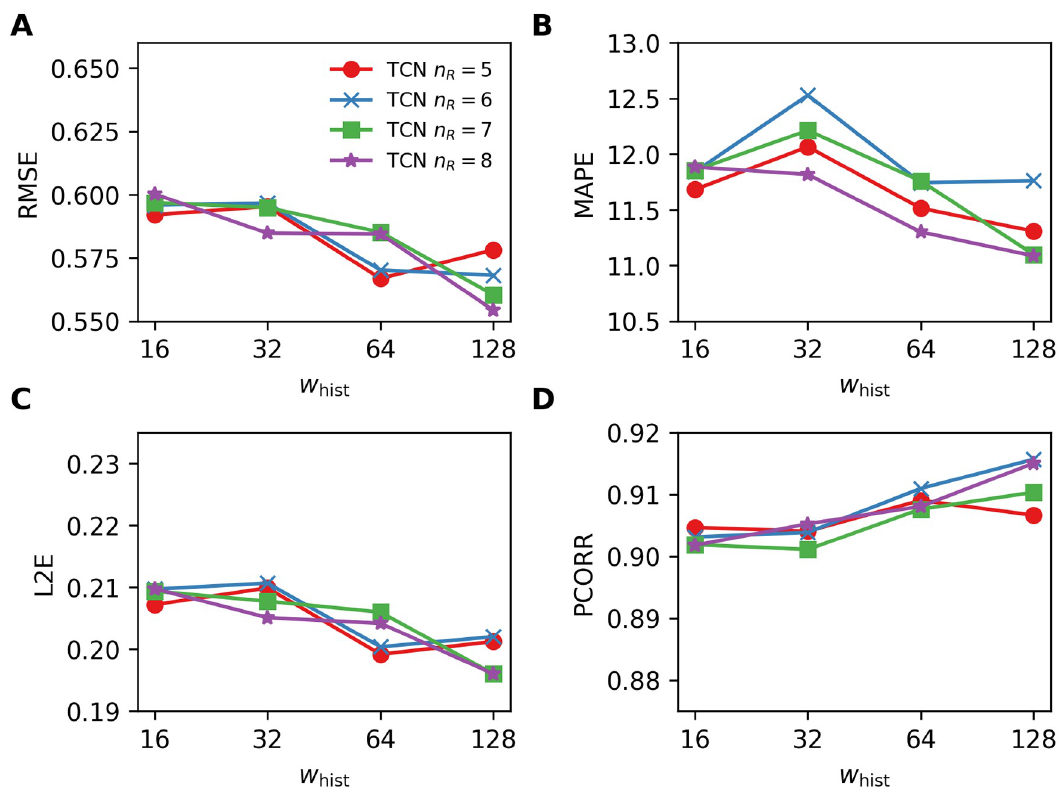
Fig 9. Four performance metrics for one-week-ahead predictions obtained by using the TCNs for varying number of residual blocks n R = {5, 6, 7, 8} with the kernel size k = 4. A. RMSE, B. MAPE, C. L2E, and D. PCORR. Smaller values are preferable for RMSE, MAPE, L2E, and larger values are preferable for